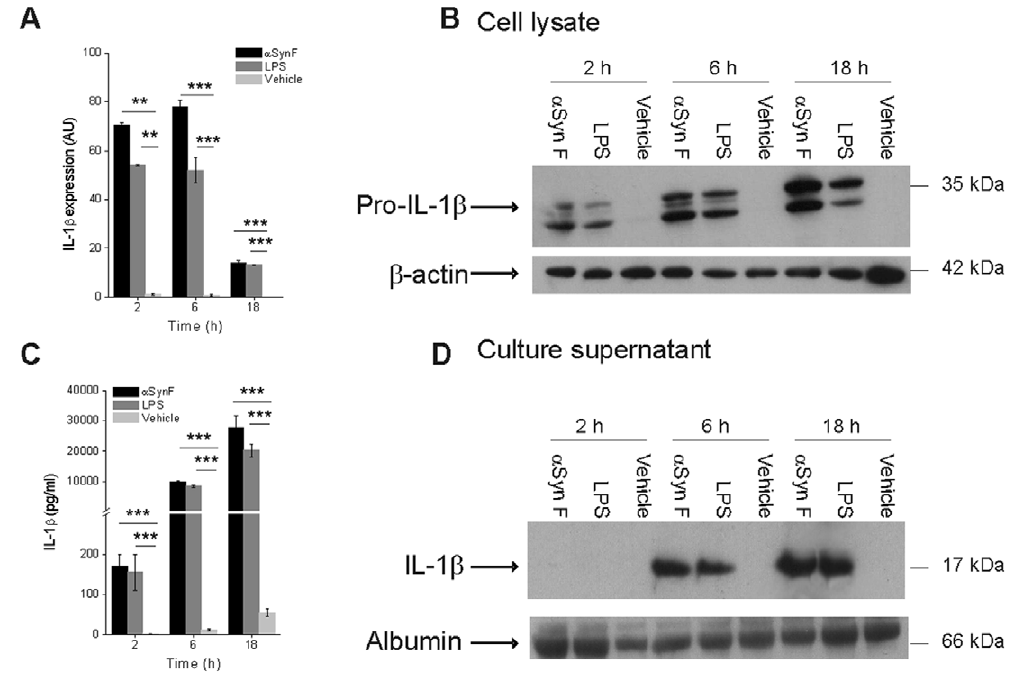
Figure 1. IL-1 b synthesis and secretion in human monocytes induced by fibrillar a Syn. (A) Monocytes were exposed for 2, 6 and 18 h to 40 nM a Syn F or 1 m g/ml LPS (positive control) or vehicle (saline) and the expression of pro-IL-1 b was evaluated by real-time PCR. Real time data are shown as the mean 6 S.D. of results obtained with cell preparations from 5 different donors; experiments with each cell preparation were conducted in duplicate. ** p , 0.01, *** p , 0.001. (B) IL-1 b synthesis was also evaluated by immunoblot analysis in cell lysates from monocytes treated as in A. The immunoblot is from one representative donor. (C) Culture supernatants from monocytes that had been harvested for quantification of mRNA levels, reported in A, were collected and evaluated for their IL-1 b content by ELISA. Results are the mean 6 S.D. of 5 determinations made in duplicate with different cell preparations derived from different donors. *** p , 0.001 (D) Culture supernatants of monocytes, harvested for the evaluation of IL-1 b synthesis, as in B, were collected and the released IL-1 b revealed in